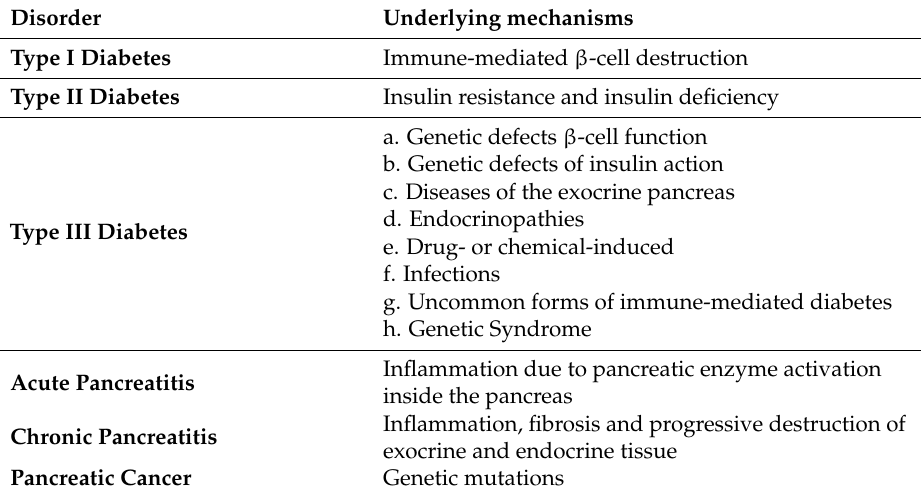
Table 1. Underlying mechanisms for diabetes and pancreatic